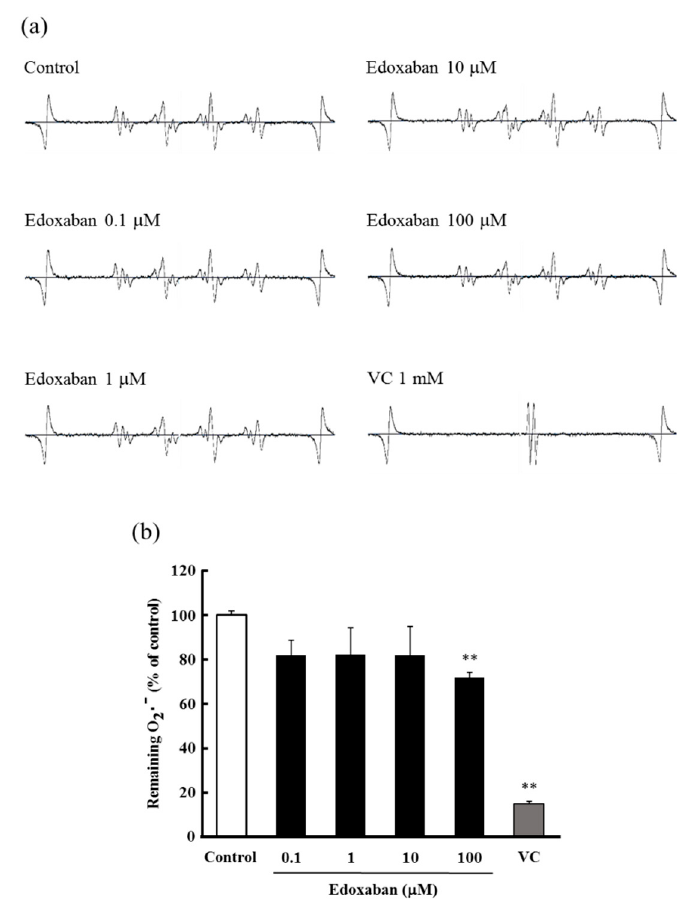
Figure 5. Effect of edoxaban on superoxide radical scavenging activity by electron spin resonance (ESR) spectroscopy. ( a ) ESR spectrum of DMPO-OOH signal in the reaction between DMPO and O 2 ·− . ( b ) Quantitation of O 2 ·− remaining. Values are expressed as the mean ± S.D. ( n = 3). ** p < 0.01 vs. control. VC: Vitamin C.